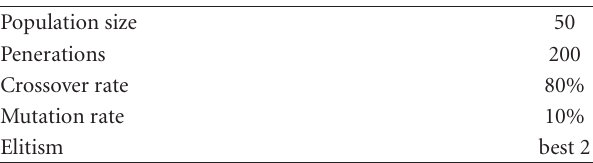
Table 1: GA configration parameters.